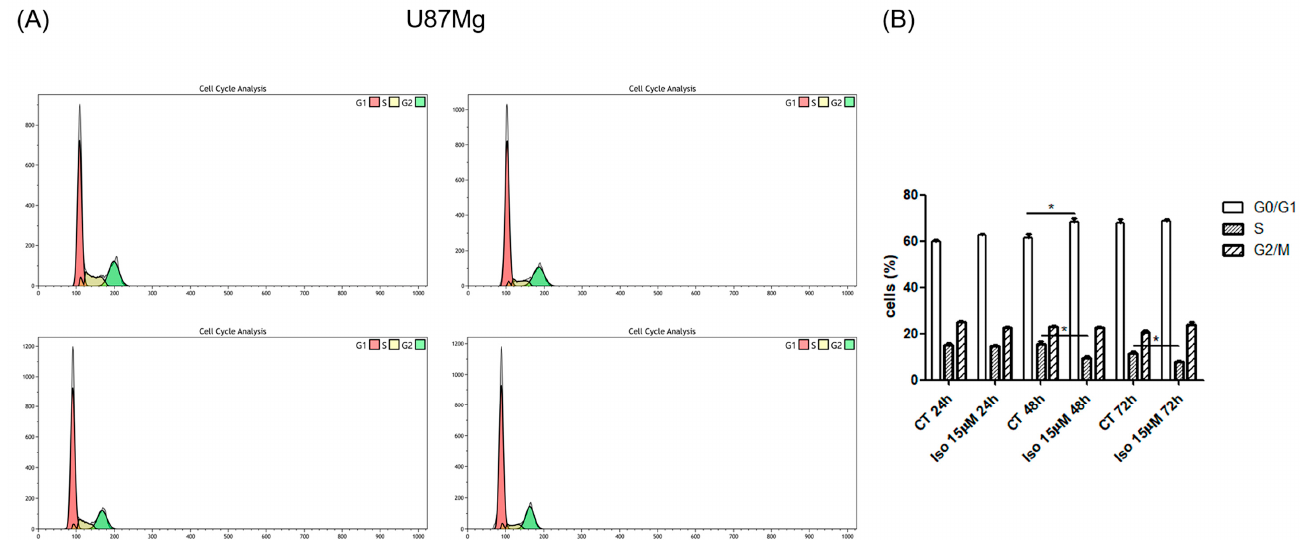
Figure 2. ( A ) Representative images of FACS analysis in U87MG cells at 48 and 72 h of treatment with Iso 15 µM. ( B ) Percentages of U87MG cells in the different phases of the cell cycle after treatment with Iso 15 µM: isoginkgetin causes a decrease of the cells in S phase and an increase in G2 phase at 48 and 72 h of treatment. Values are the means ± SEM of three individual measurements: unpaired t -test, one-way ANOVA test, Bonferroni’s multiple comparison test, p -values < 0.05. According to GraphPad Prism, * p value 0.01 to 0.05 (significant).